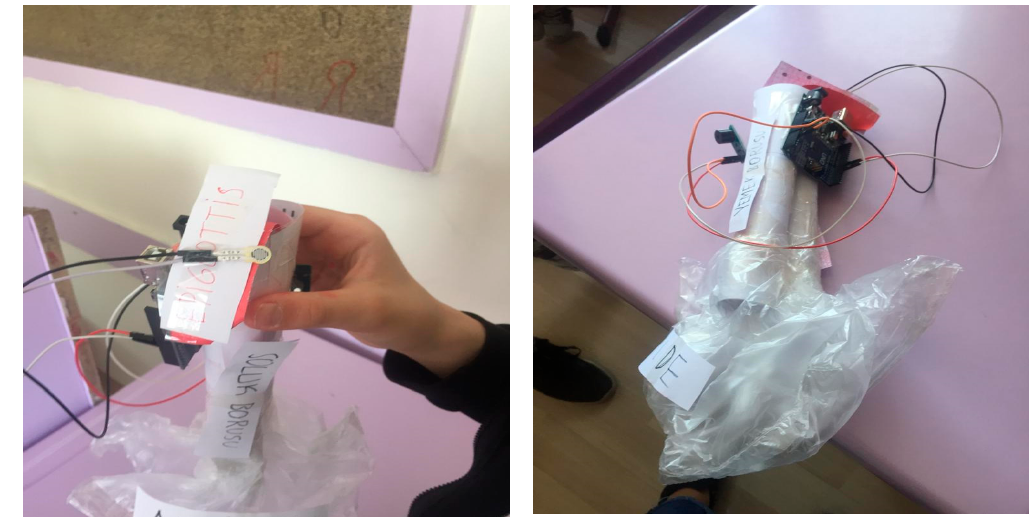
Figure 2. Epiglottis model with a thin film pressure sensor .